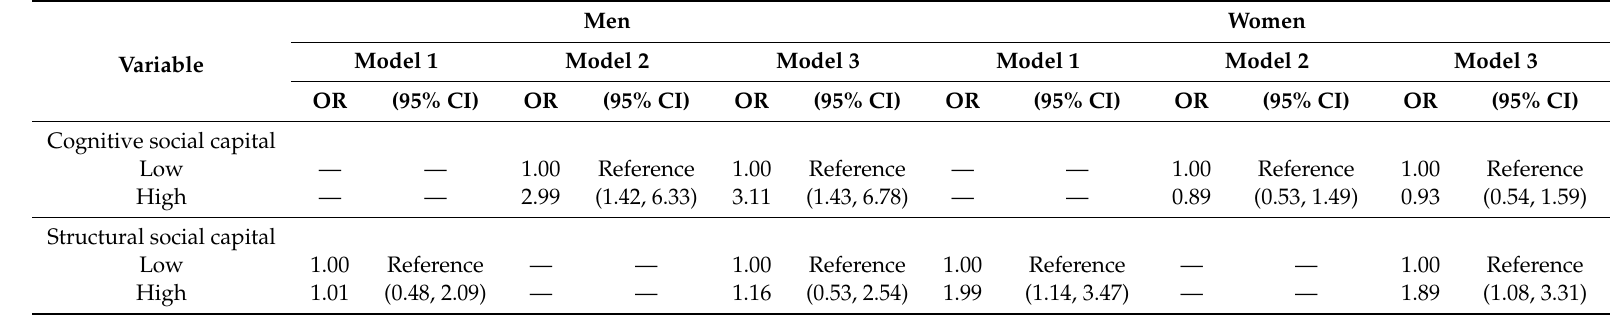
Table 2. Relationship between social capital and cognitive function according to